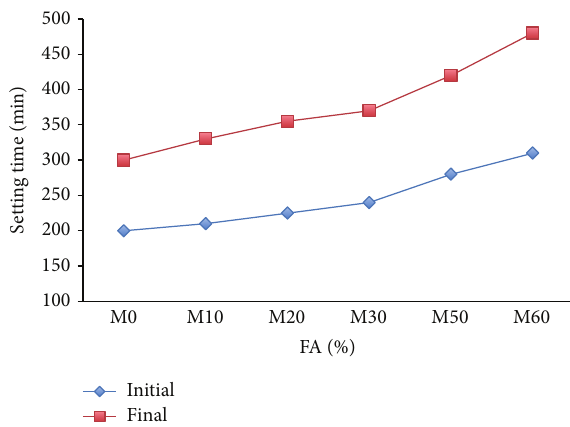
Figure 3: The effect of FA on the setting time of mortar mixes without